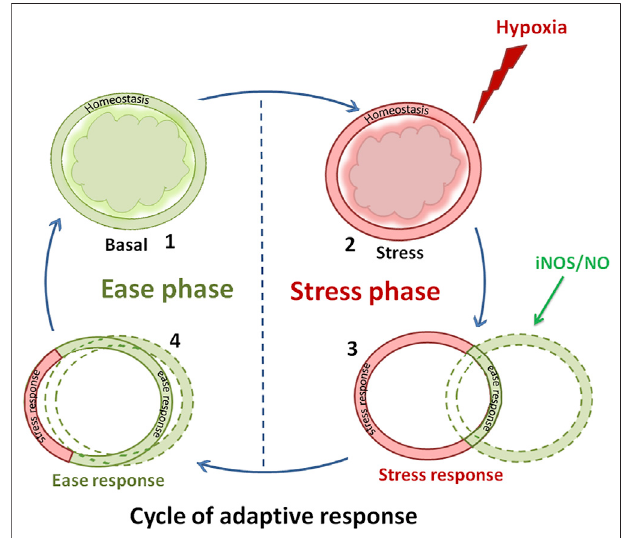
FIGURE 1 | Schematic chart showing the cyclic events associated with the adaptive response that happens in an organism when it encounters stressors such as hypoxia. In this cycle of adaptive response, the organism exhibits a basal homeostatic state due to its nonstressed condition (Panel1.1).Butlater,theorganismperceivesstressstimulusfromhypoxia.For example, when an air-breathing fi sh was held in water, it experienced hypoxia as a result of forceful submergence (immersion) (Panel 1.2). Here, the fi sh enters the stress phase and shows stress response (Panel 1.2). When these fi sh were treated with L-NAME, activation of the iNOS/NO system occurs in their ionocytes that induces multidimensional regulation of NKA. This brings a new drive to initiate ease response in this fi sh, though its contribution is little at that stage of the stress phase (Panel 1.2). However, in the next stage, the fi sh were able to utilize the fullest iNOS/NO system to lower the magnitude of the stress response as evident in the overlapping of the highest ring of ease response (Panel 1.3). In stage 3, the fi sh were able to show a substantial degree of ease response, though minimal stress response could also be sustained in that stage (Panel 1.4). While staying in this phase of ease, the fi sh couldbebroughtbacktoitsbasalhomeostasisstage(Panel1.1).Atthisbasal homeostatic stage, the fi sh could again experience another stress stimulus and corresponding stages could be achieved repeatedly by running the events of the cycle again. This constitutes the cycle of adaptive response with two phases, namely, stress and ease phase (Panel